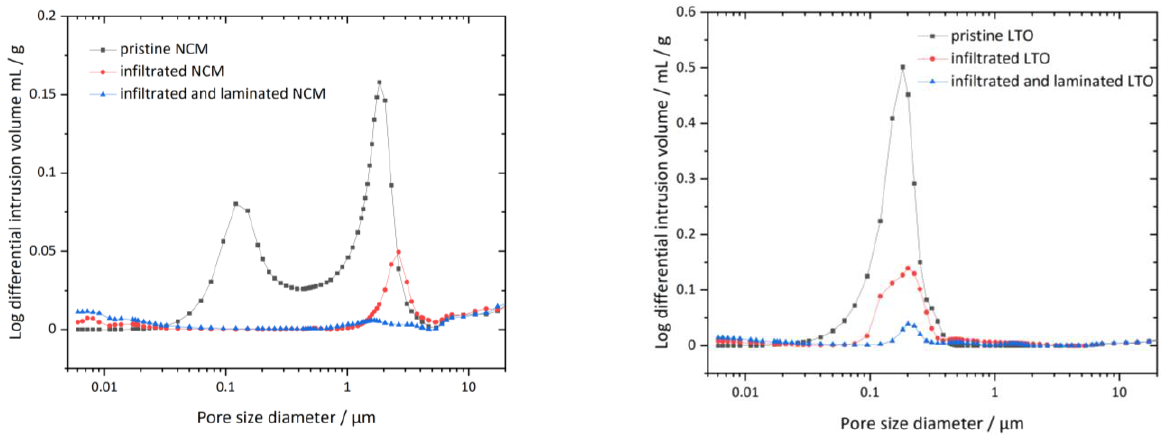
Figure 4. Pore size distribution measured through Hg-porosimetry; ( Left ): NCM; black: porous NCM electrode; red: PCCE infiltrated NCM; blue: PCPE infiltrated and isostatically laminated NCM; ( Right ): LTO; black; porous LTO electrode; red: PCPE infiltrated LTO electrode; blue: PCPE infiltrated and isostatically pressed LTO electrode.